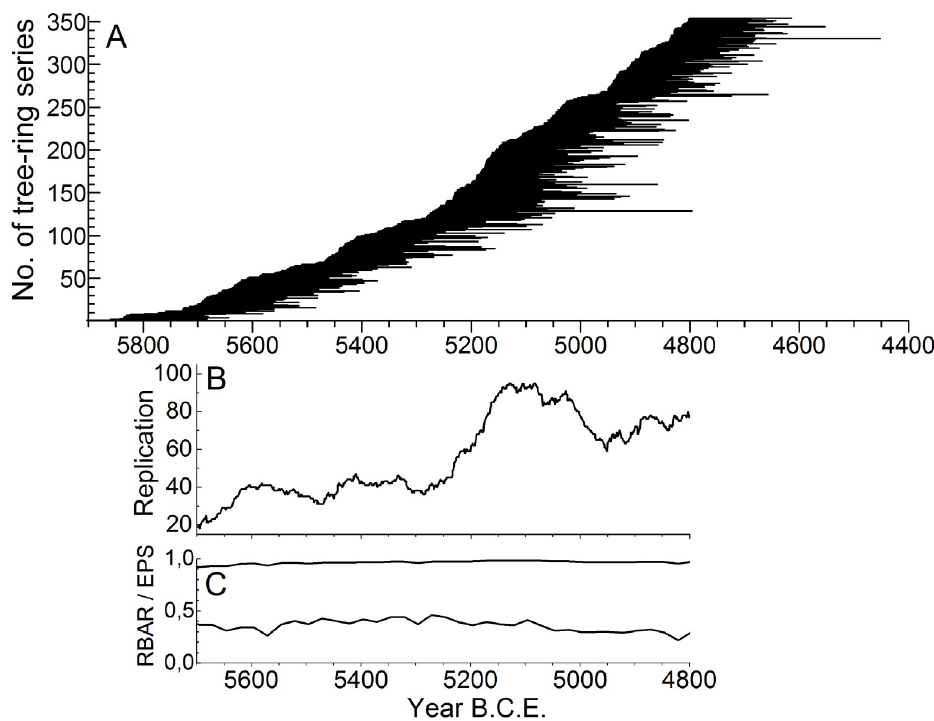
Fig 5. Tree-ring series used for precipitation reconstruction. (A) Lifespan of the oak trees from Main region, (B) replication (number of tree-ring series per year) and (C) inter-series correlation (RBAR) / Expressed Population Signal (EPS).